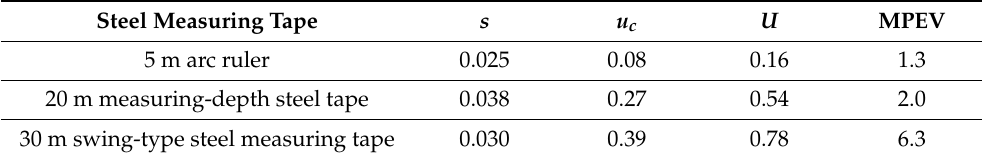
Table 2. Each steel measuring tape’s s , u c , U ( k = 2), and MPEV (unit: mm). Steel Measuring Tape